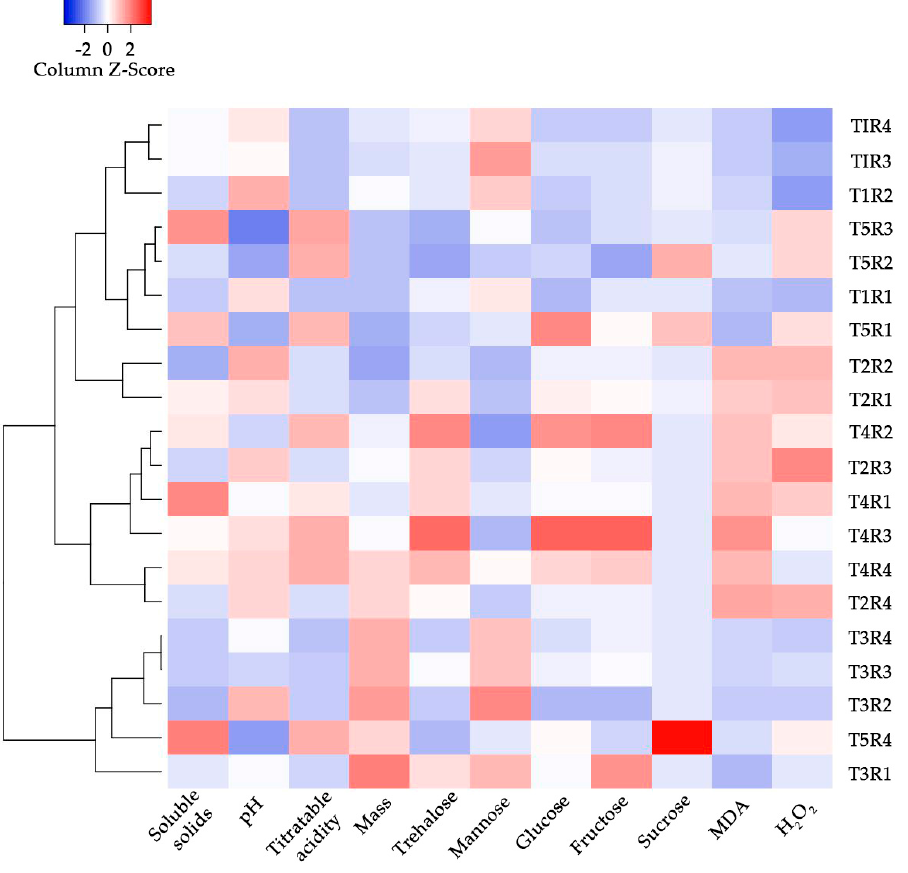
Figure 4. Heat map at 175 DAFA in atemoya ( Annona × atemoya Mabb.) fruits cv. Thompson. Medium values. Botucatu, S ã o Paulo, Brazil, 2021. DAFA: Days after the first Cu(OH) 2 application (plants with flowers and fruits in initial stage). T1 (control)—absence of Cu(OH) 2 ; T2—7.8 mL Cu(OH) 2 L − 1 of water divided into two applications; T3—15.6 mL Cu(OH) 2 L − 1 of water divided into four applications (the recommended dose by MAPA); T4—8.0 mL Cu(OH) 2 L − 1 of water divided into eight applications; and T5—13.0 mL Cu(OH) 2 L − 1 of water divided into thirteen applications.